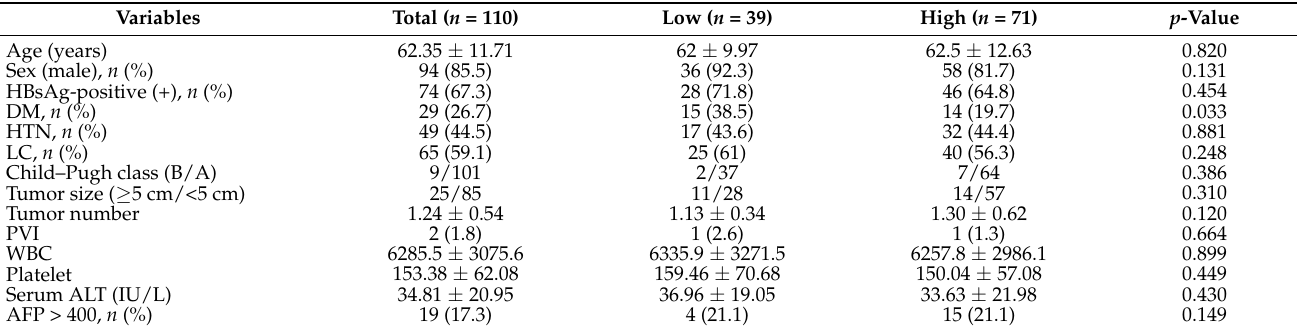
Table 1. Clinical characteristics according to PrP C expression.